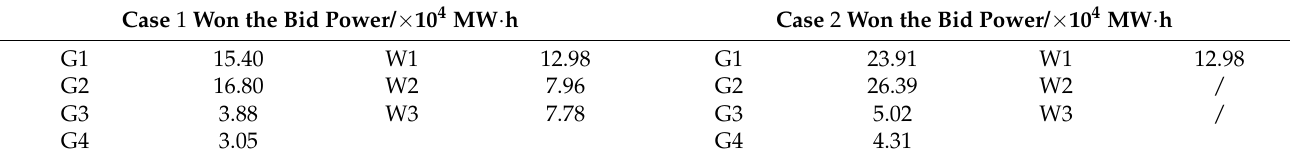
Table 3. Wind-Fire Electric Bidding Transaction Results.